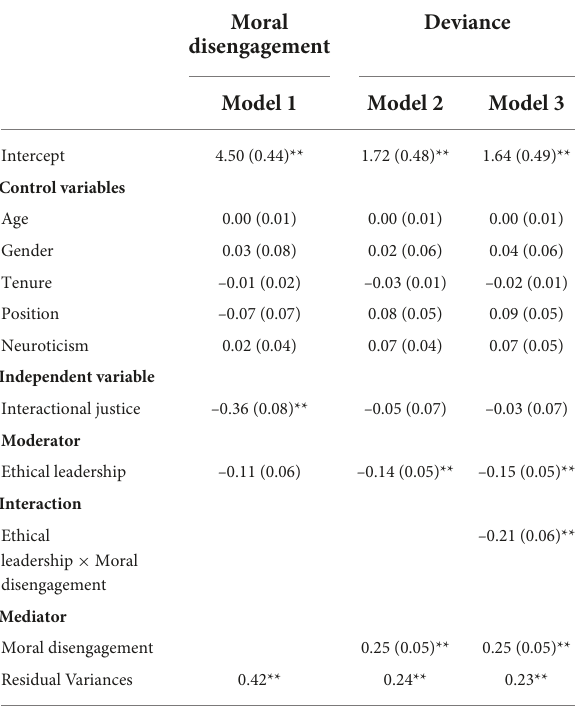
TABLE 3 Multilevel path analysis results.